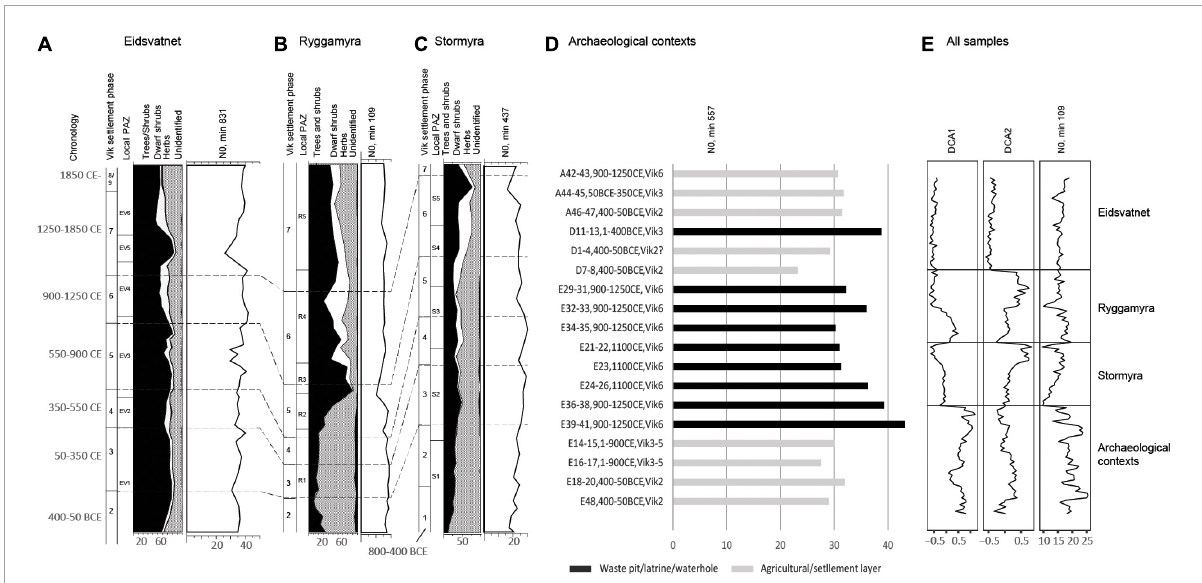
FIGURE5 Palynological richness (N0) in relation to settlement phases (A) Eidsvatnet, (B) Stormyra, (C) Ryggamyra, and (D) archaeological contexts. (E) Palynological richness and Detrended Correspondence Analysis (DCA) sample scores for the four datasets treated